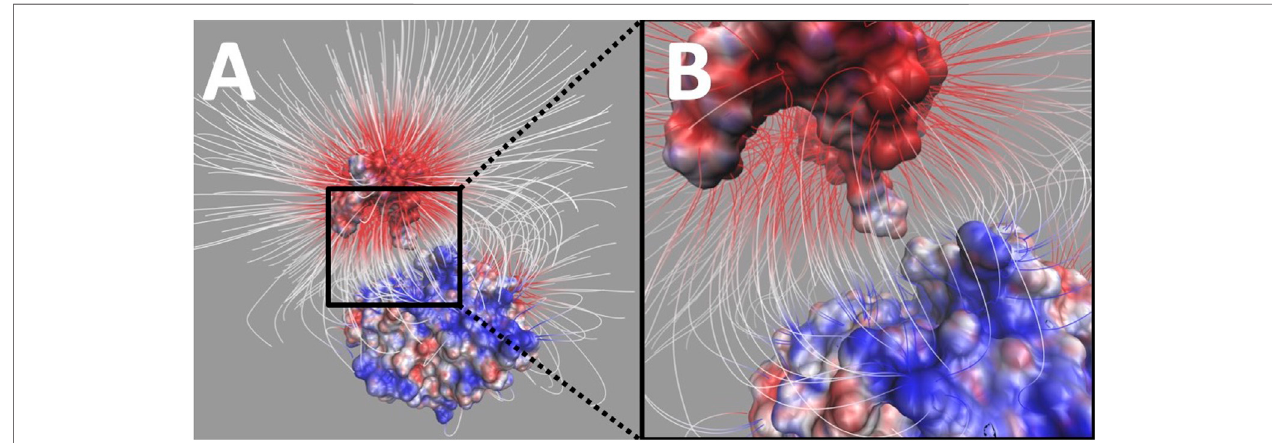
FIGURE 7 | Electrostatic fi led lines between DNA and UDG. (A) The overall view of electrostatic fi led lines distribution between DNA (top) and UDG (bottom). (B) A closeup of electrostatic fi eld lines distribution between DNA (top) and UDG (bottom) at the interface area. Visual molecular dynamics (VMD) (Kortemme et al., 2004) was implementedbased onthe electrostatic potential map from DelPhi calculations, and thecolor scale range wasset from − 3.0 to3.0 kT/e. Forthebetterrepresentation of electric fi eld lines, we chose the line size to be four and delta value to be 0.25, and set gradient magnitude value 3.64 (which shows the lines within the volumetric). Besides, those selected fi eld lines for display have the minimum line length of 4.12 and maximum line length of 35.31.